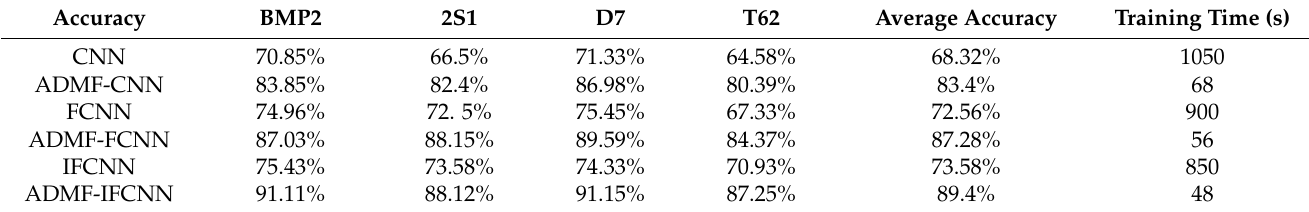
Table 2. Experimental results of four types of target classification.